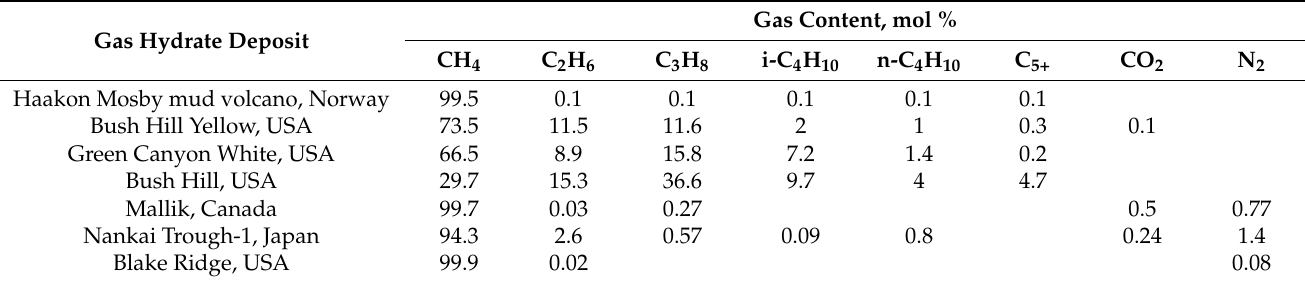
Table 3. Composition of gases in natural gas hydrates